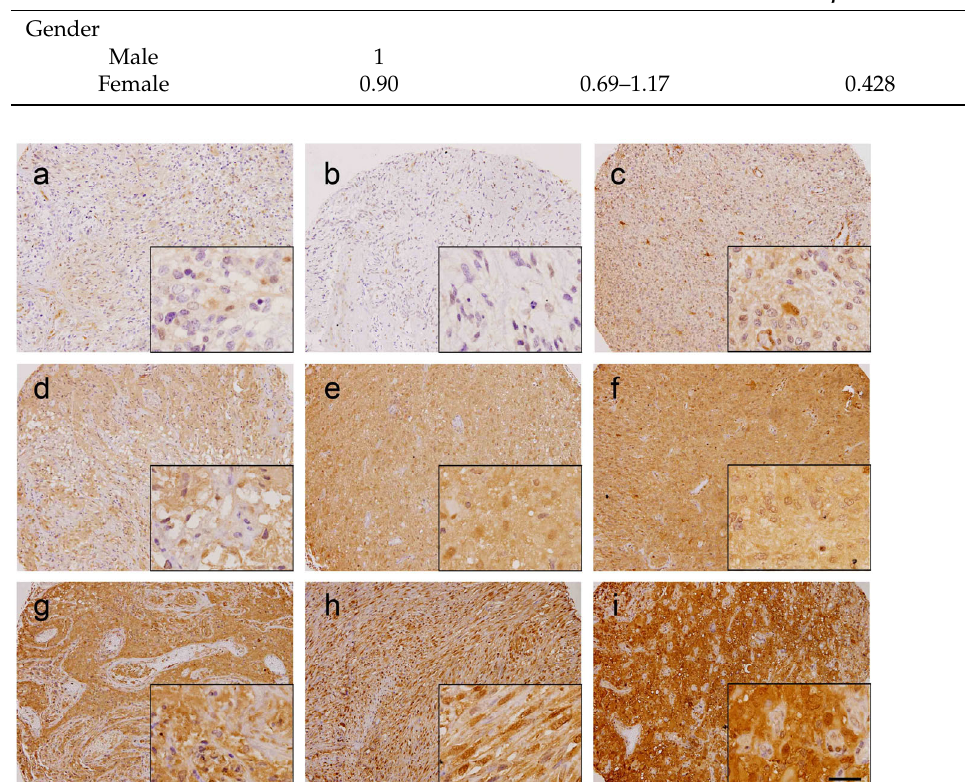
Figure 1. Gal ‐ 1 immunohistochemistry in glioblastoma tissue microarray (TMA). Representative images of selected “low Gal ‐ 1” (panels ( a – c ), H ‐ Score < 129.3) or “high Gal ‐ 1” (panels ( d – i ), H ‐ Score ≥ 129.3) glioblastoma cores are shown. Scale bar, 100 μ m (low magnification) or 25 μ m (high mag ‐ nification inserts).